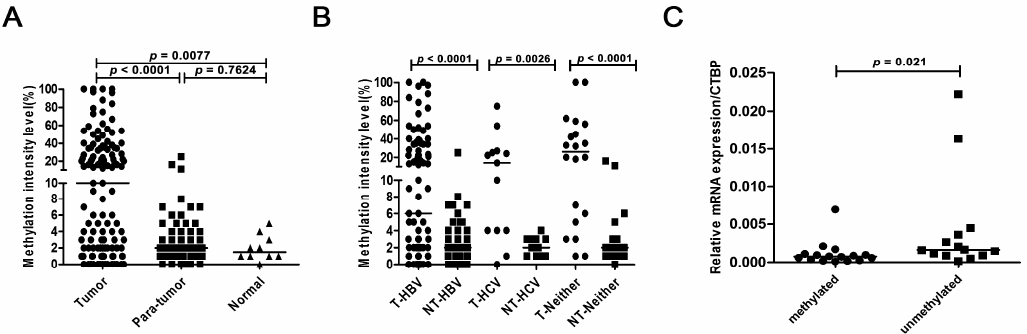
Figure 4. Methylation status of BNC1 in HCC tissues. ( A ) The methylation intensity of BNC1 in 127 pairs of HCC tumor tissues and adjacent non-tumor tissues and 10 normal liver tissues; ( B ) The methylation intensity of BNC1 in paired tumor tissues with different infection background. “T” represents tumor tissue; “NT” represents non-tumor tissue; “ − HBV” represents with hepatitis B virus (HBV) infection; “ − HCV” represents with hepatitis C virus (HCV) infection; “ − Neither” represents without evidence of hepatitis viral infection; ( C ) The expression level of BNC1 mRNA in methylated HCC tissues (methylation intensity ≥ 10%) and unmethylated tissues (methylation intensity <10%). The horizontal black lines in the picture represent mean values.